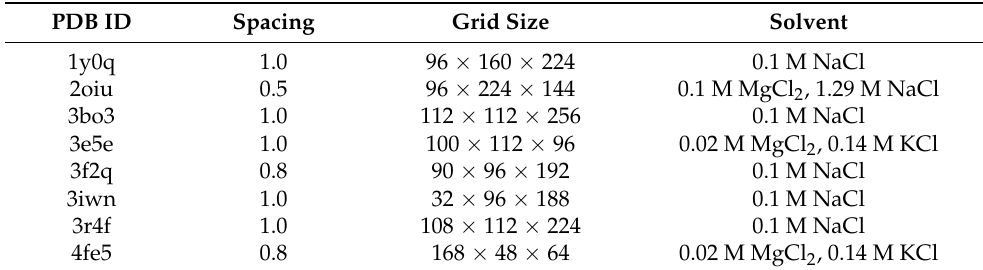
Table 2. 3D-RISM parameters. Grid spacing in Å. PDB ID Spacing Grid Size Solvent 1y0q 1.0 96 × 160 ×